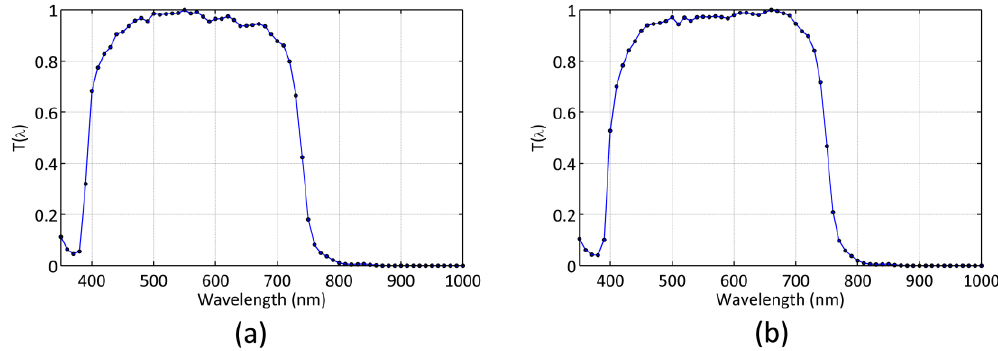
Figure 1. Normalized spectral sensitivity of the Telescope Encoder and Sky Sensor (TESS-W) night sky brightness meters ( a ) stars3, and ( b ) stars222 Table 1. Calibration constants of the TESS-W night sky brightness meters.